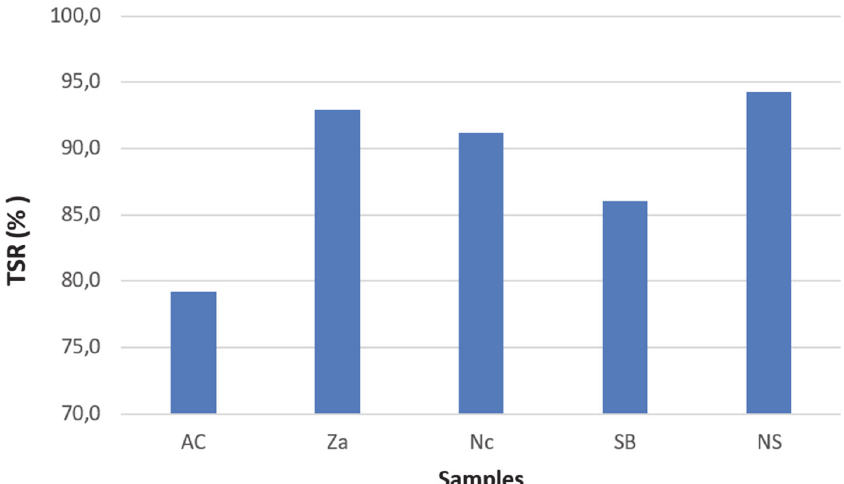
Figure 5: Quantitative results of moisture susceptibility for modified and non-modified specimens.